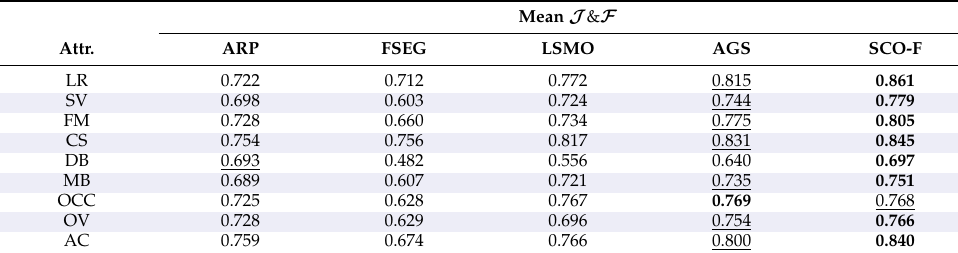
Table 7. Attribute-based performance comparison on the validation set in DAVIS2016. Attr.